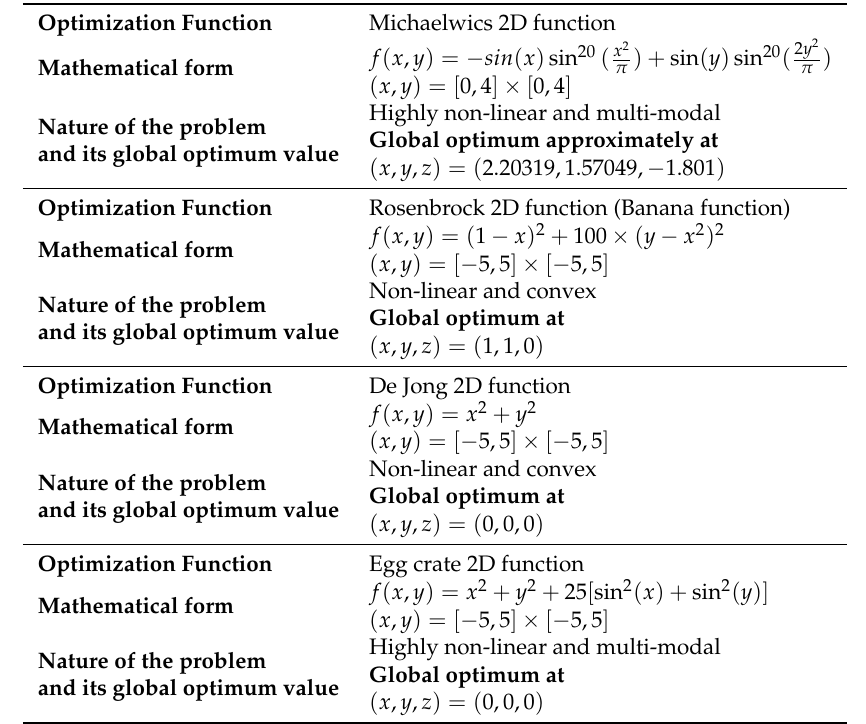
Table 16. Selected functions for the validation of the proposed improved